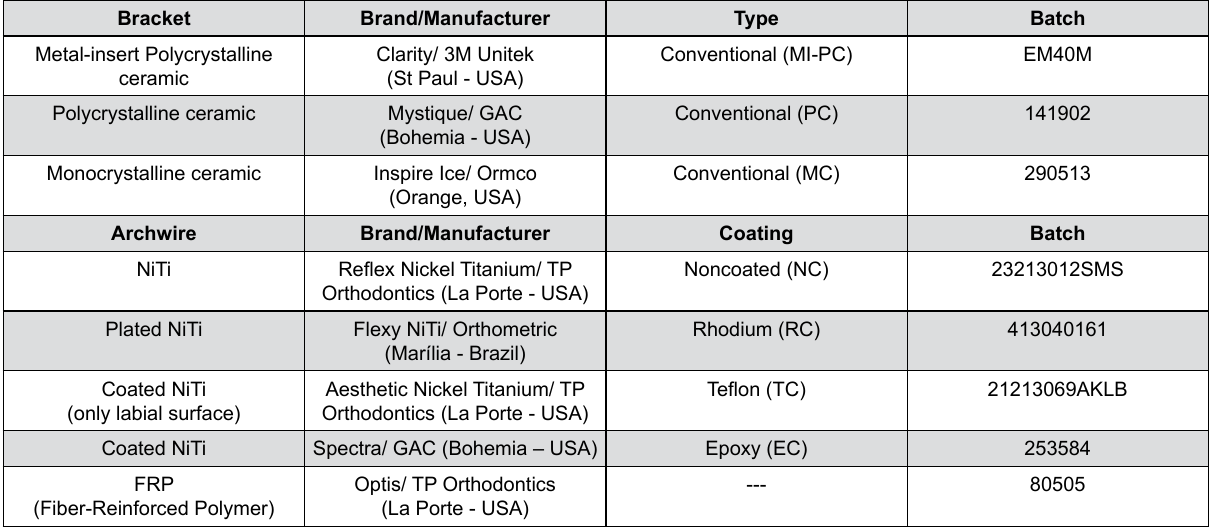
Figure 1- Experimental groups of brackets (0.022x0.028-in) and archwires (0.016-in)